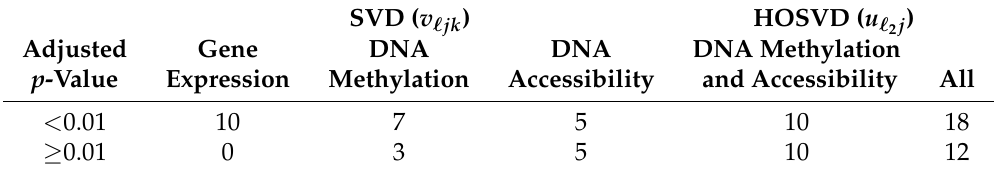
Table 4. Number of singular-value vectors coincident with the classification shown in Table